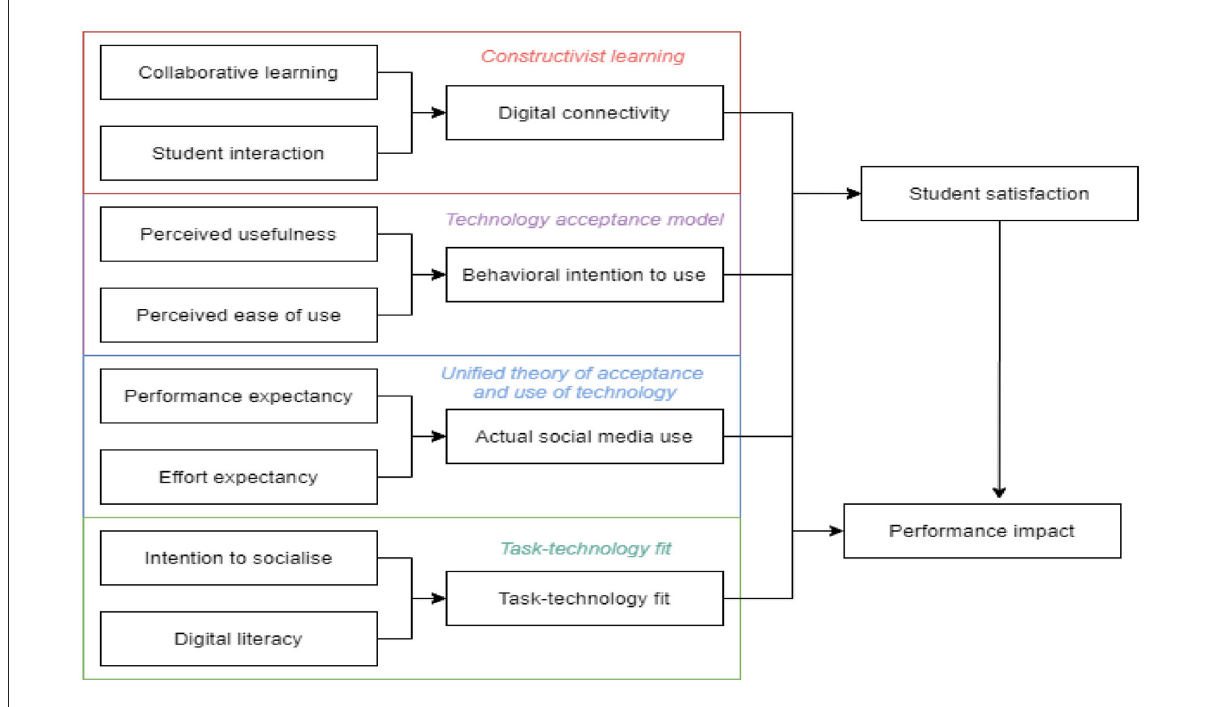
FIGURE1 Research model and